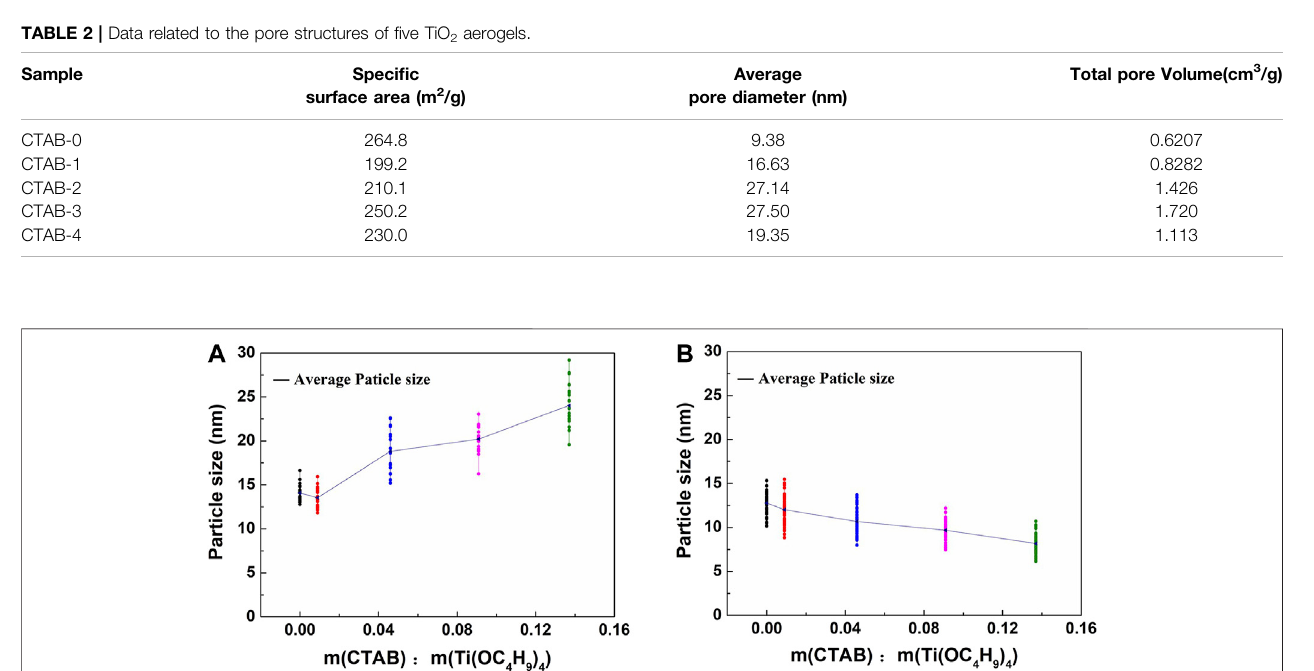
Frontiers in Materials |